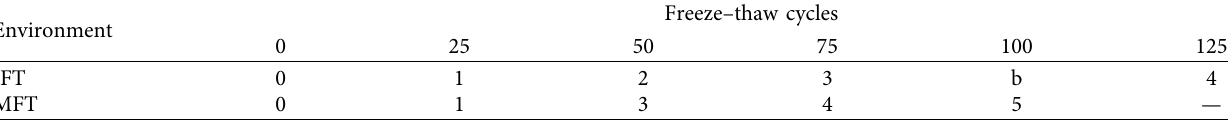
Table 8: Visual assessment a of specimens’ deterioration in concrete specimens.